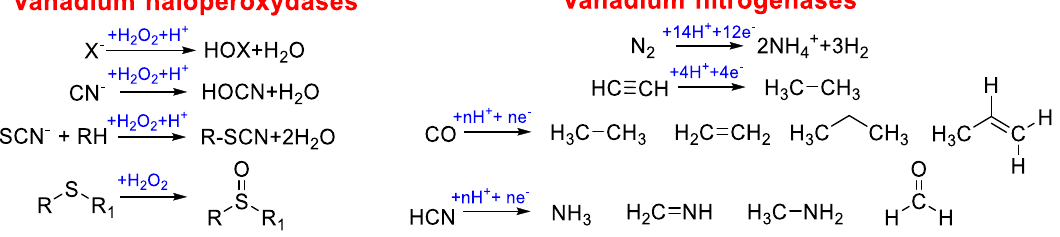
Figure 2. Catalyzed reactions performed by vanadium haloperoxydases and vanadium nitrogenases [39].